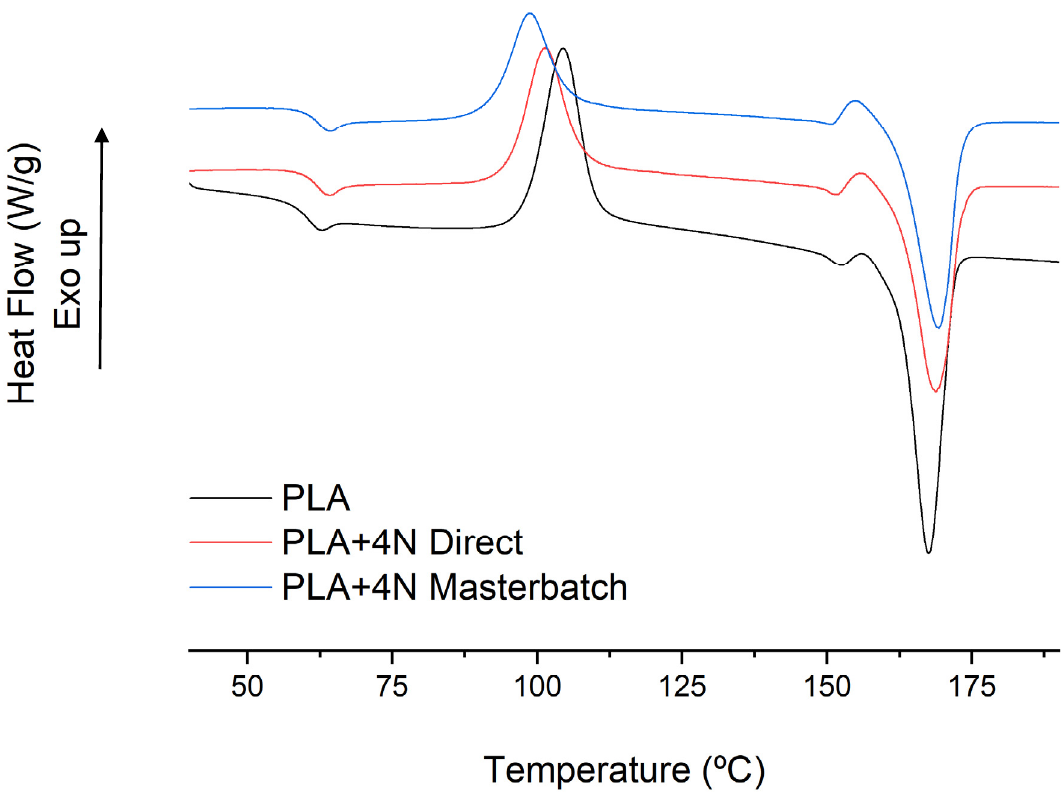
Figure 4. DSC thermograph of PLA and PLA nanocomposites produced with both methodologies.